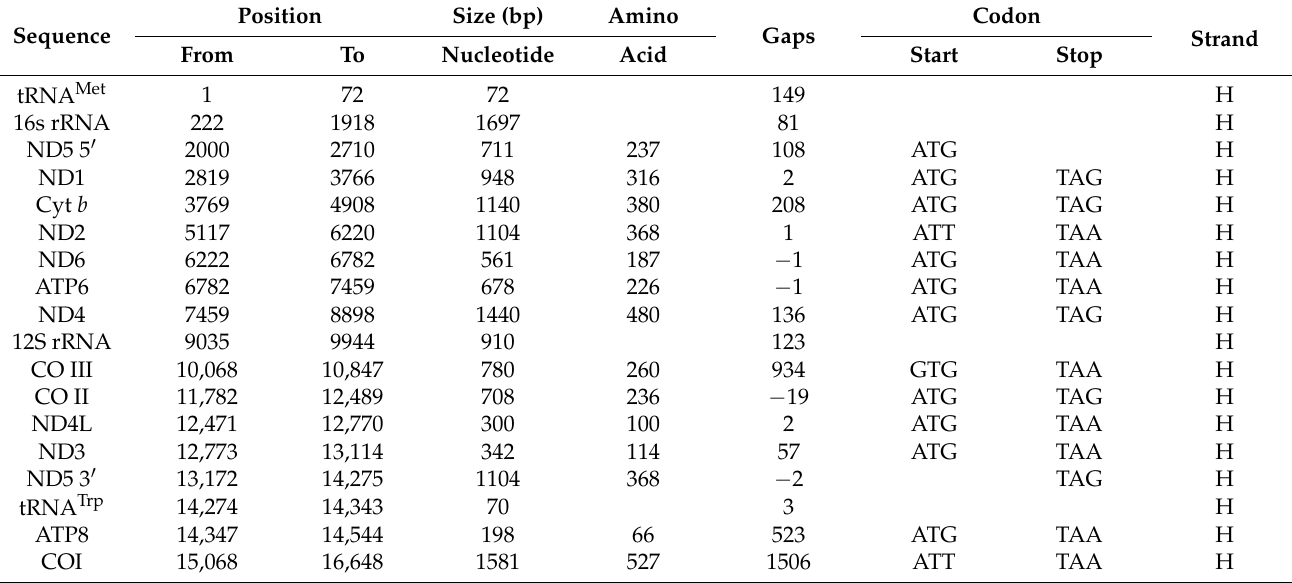
Table 2. Organization of the mitogenome of H. bowerbanki .